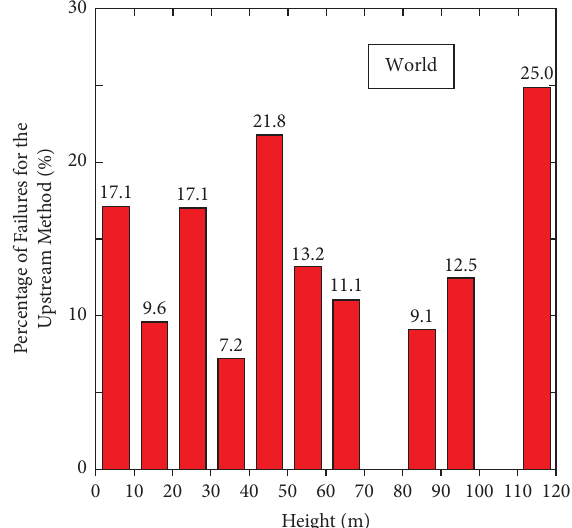
Figure 19: Percentage of upstream raised tailings dams failed per dam height at failure (data from Bowker [22] and Torrez-Cruz [32]).